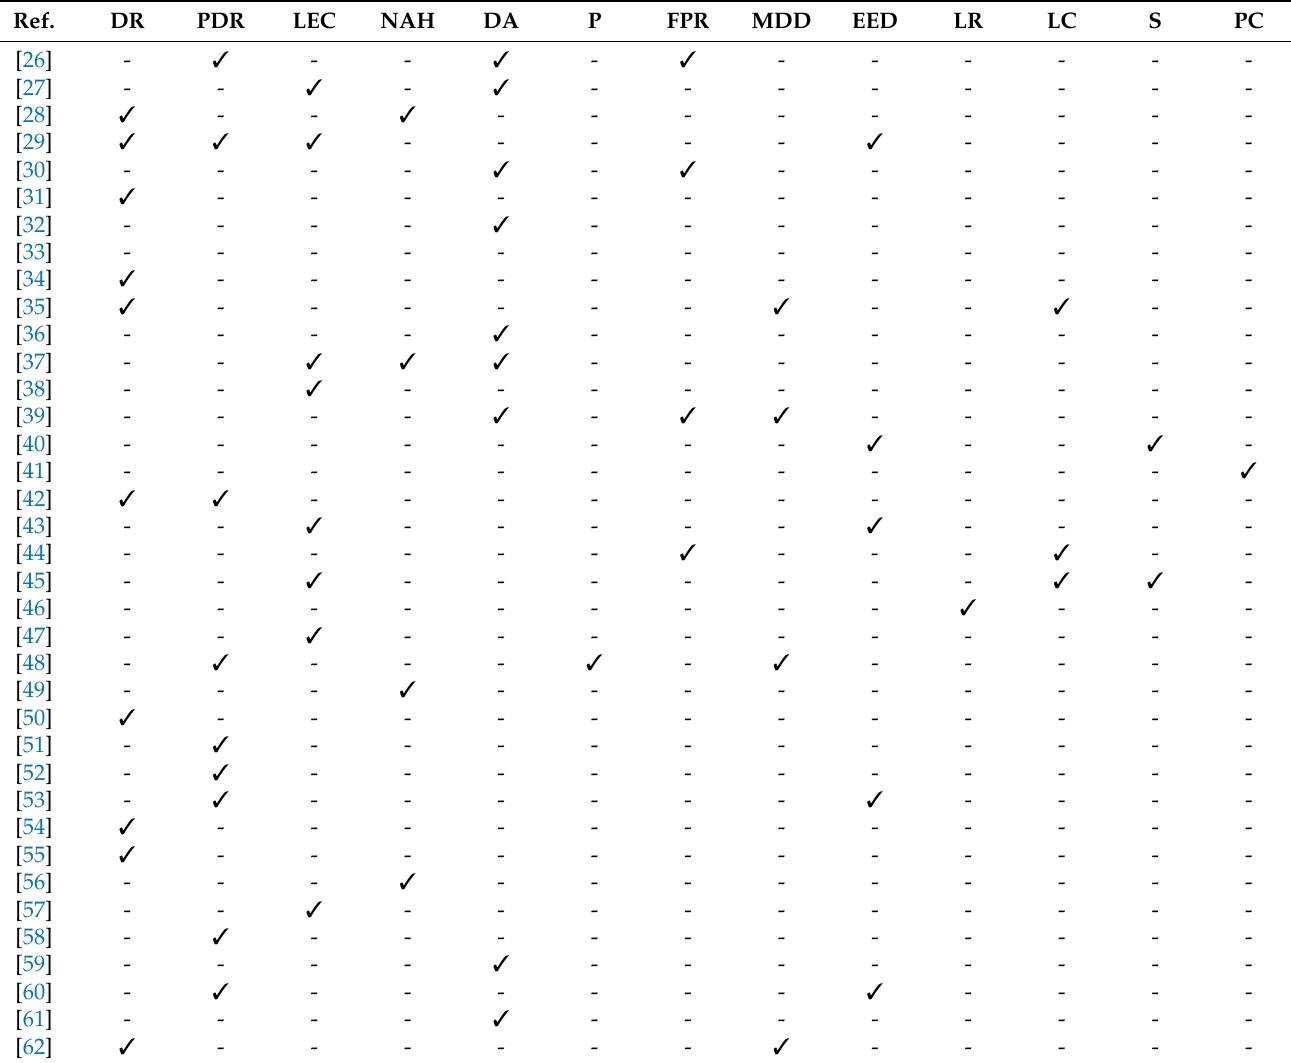
Table 3. Objective-based